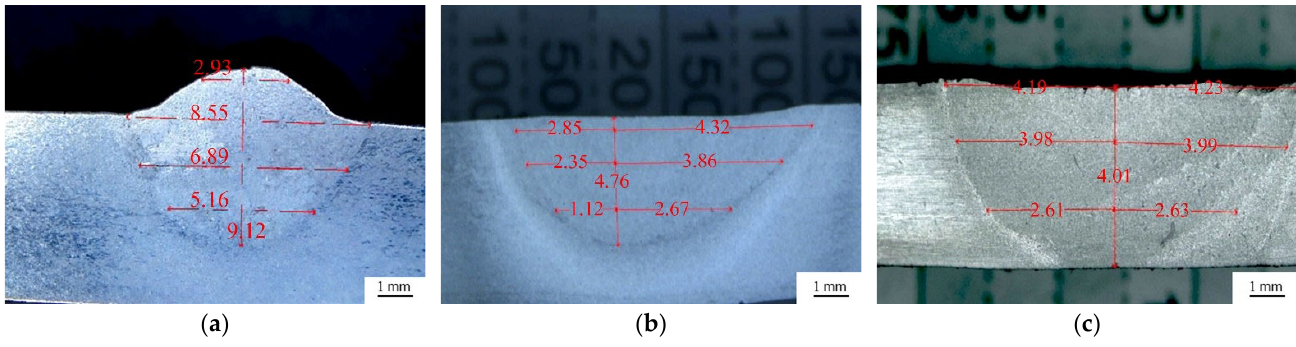
Figure 6. Physical map of weld formation under different technological conditions. ( a ) B = 0 T, ( b ) B = 0.03 T, ( c ) B = 0.03 T + 3 mg/cm 2 NiCl 2 .